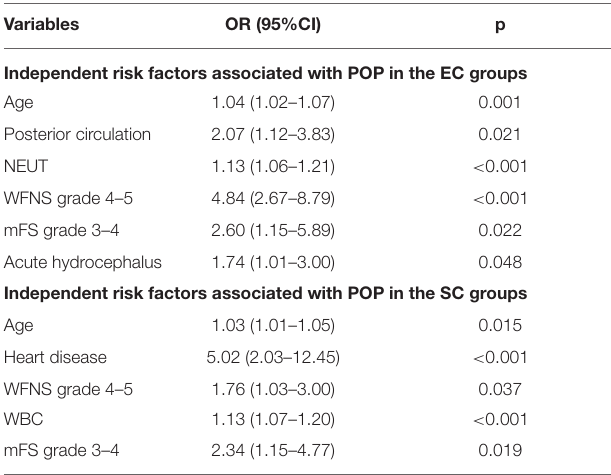
TABLE 6 | Independent risk factors associated with postoperative pneumonia (POP) in the endovascular coiling (EC) and surgical clipping (SC) groups.